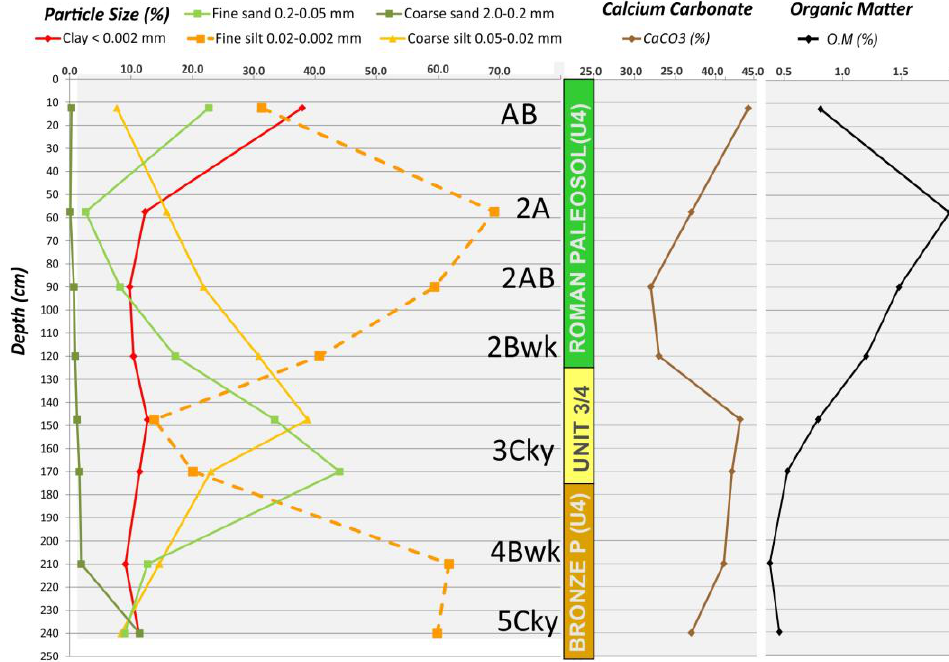
Figure 5. Graphics displaying the percentages (%) of particle size distribution, organic matter and calcium carbonate contents, with depth of the studied paleosols. See location of the different soil horizons in Figure 2.